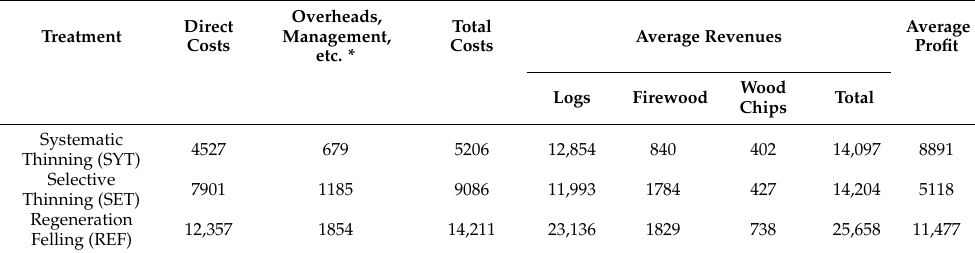
Table 5. Summary data of economic balance obtained by the models’ application as a function of the average weight of the tree for the three treatments (EUR ha − 1